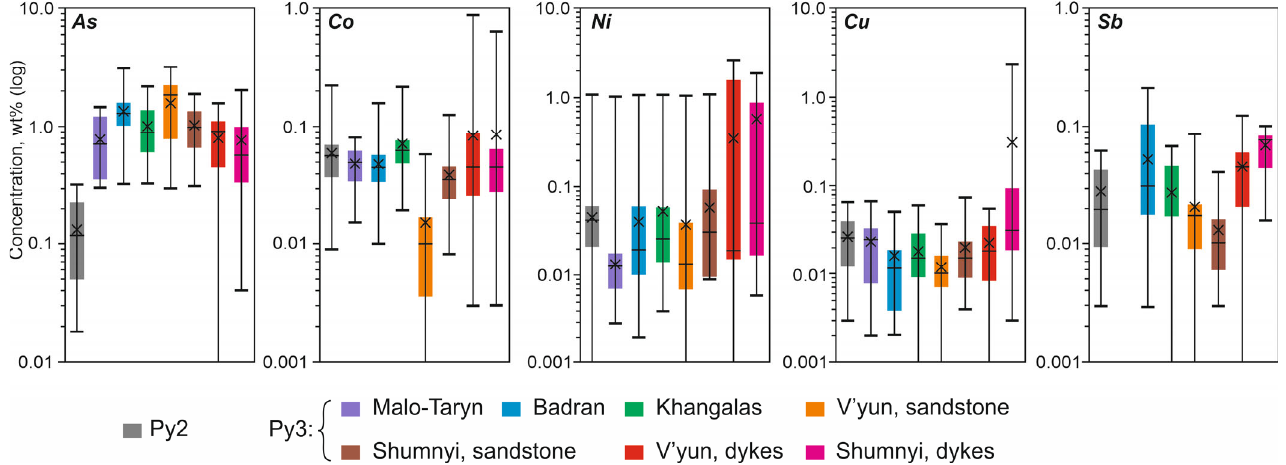
Figure 12. Boxplots showing the compositional difference in Py1-2 and Py3 acquired using an EPMA analysis of the studied OGDs, central YKMB. The lower border of the line shows the minimum value; the upper shows the maximum value. Horizontal lines in the boxes denote the median, the X marks in the boxes denote the mean, and the bottom and top of each box denote the first and third quartiles, respectively. Concentrations are on a logarithmic scale.